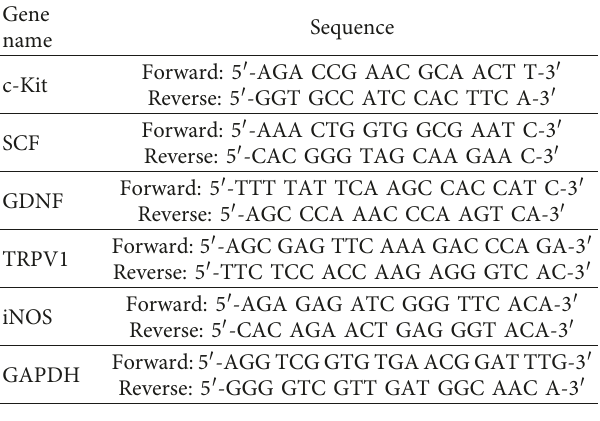
Table 1: Sequences of primers used in the qPCR assay.